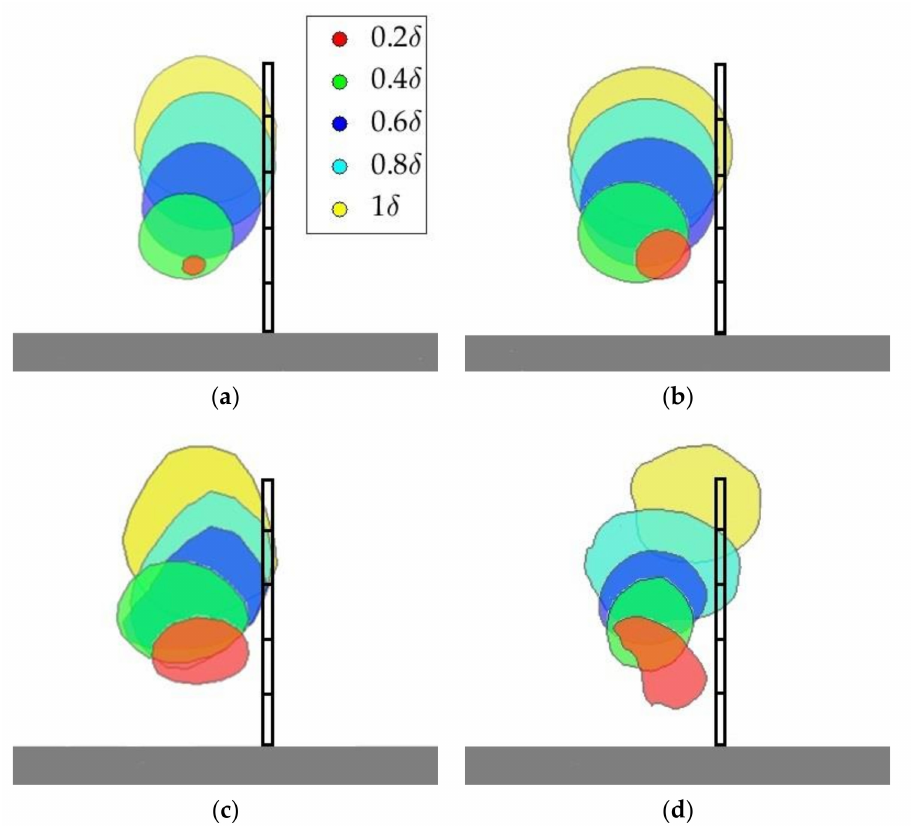
Figure 9. Primary vortex represented by the Q-criterion with a value of Q = 2500 s − 2 . The black squares are the projections of the VG Trailing Edges: ( a ) RANS Fully Resolved Mesh model ( α = 18 ◦ ), ( b ) RANS cell-set model ( α = 18 ◦ ), ( c ) LES fully resolved mesh model ( α = 25 ◦ ), and ( d ) LES cell-set model ( α = 25 ◦